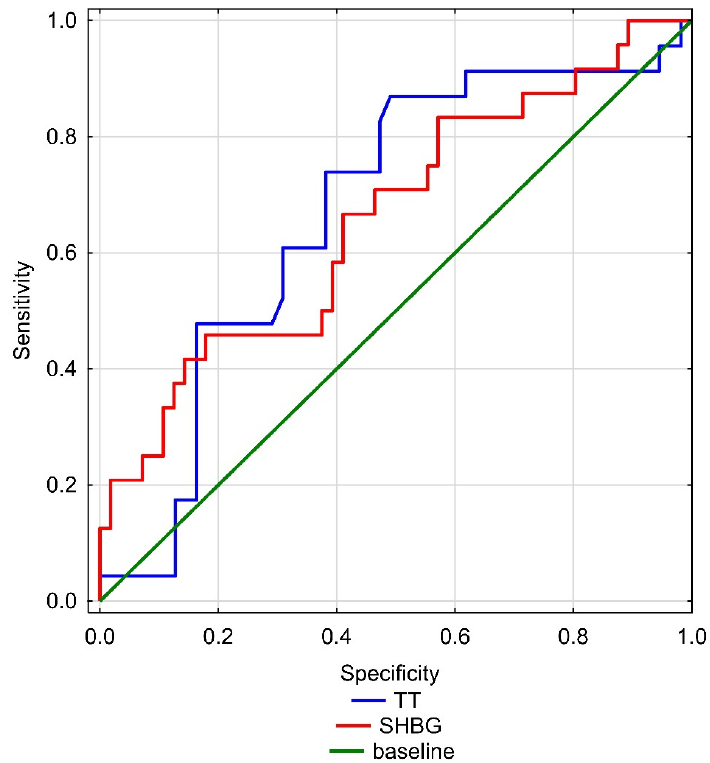
Figure 1. Receiver operating characteristics of the concentrations of TT (blue line) and SGBH (red line) for the International Index of Erectile Function.